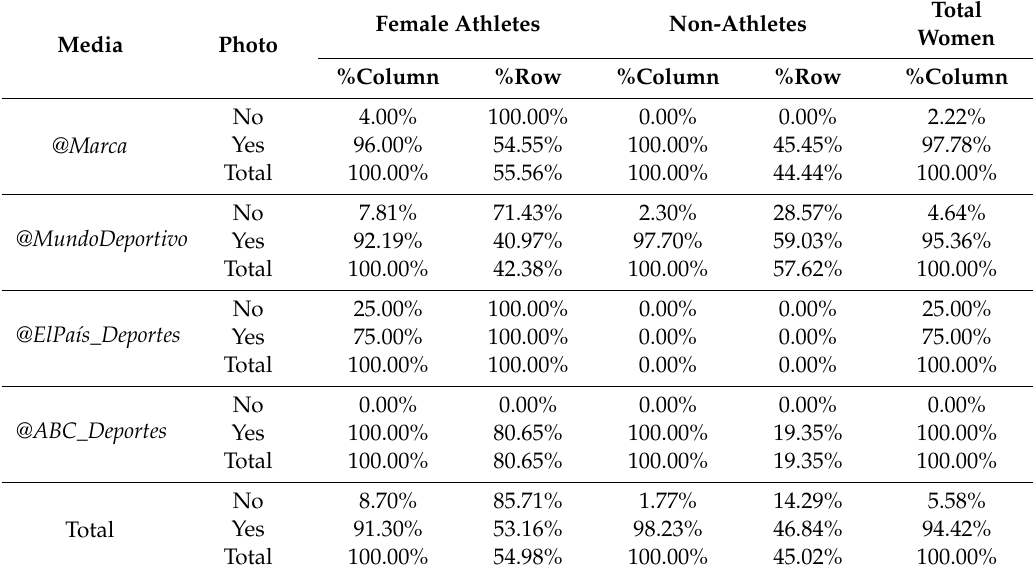
Table 9. Distribution of the profile of “women represented” (athletes vs non-athletes) according to the communication media and accompanying photo in tweet (n =